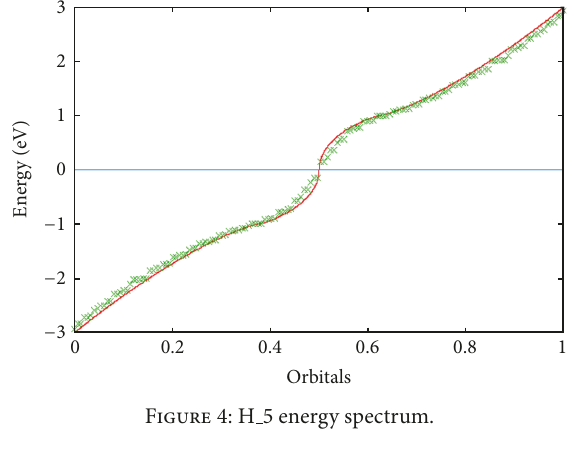
Figure 4: H 5 energy spectrum.